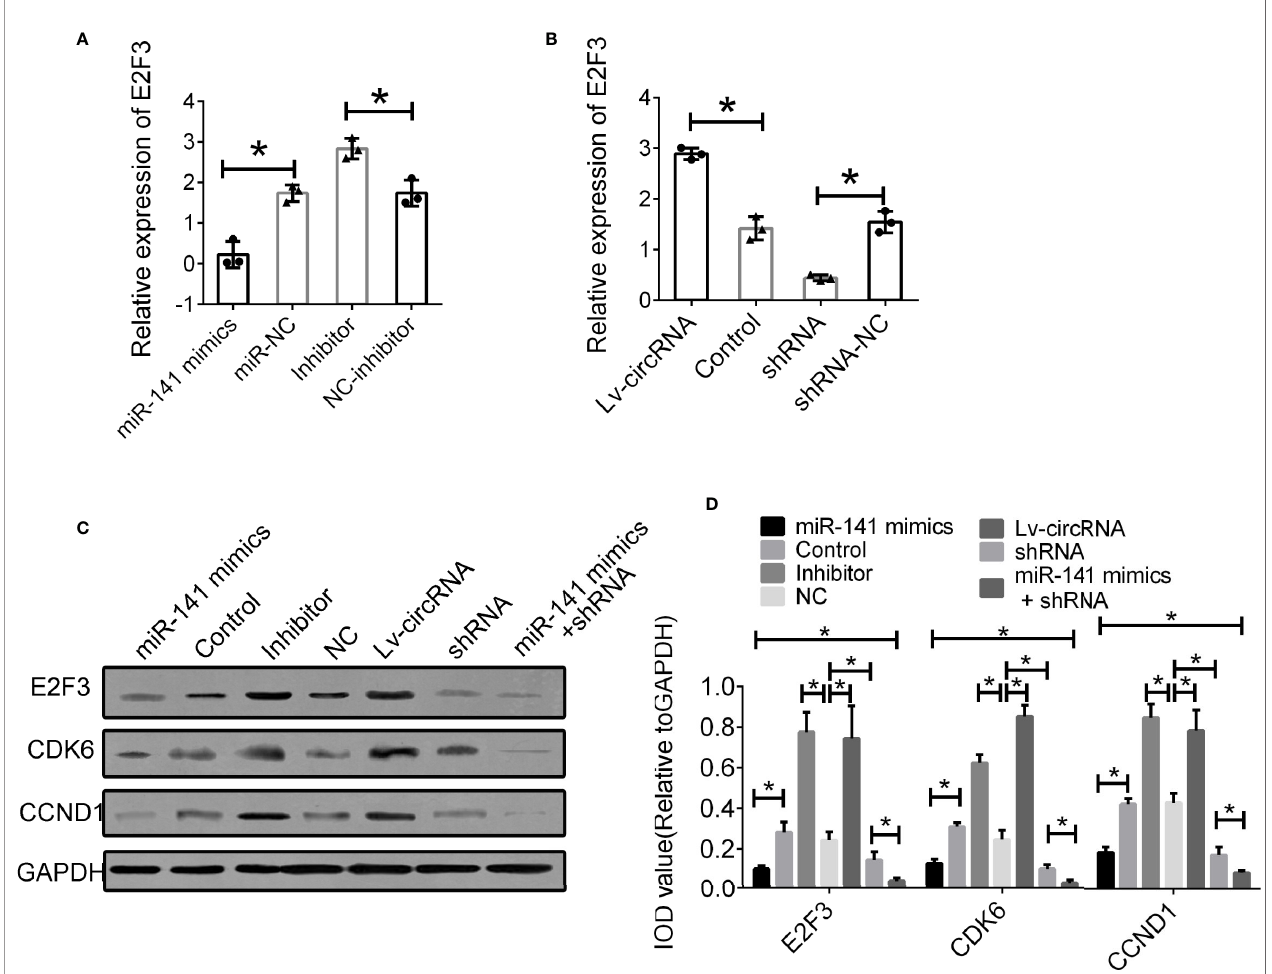
FIGURE 6 | Interaction between circ_0032822, miR-141 and E2F3. (A) Relative mRNA expression of E2F3 in cells treated with miR-141 mimics or inhibitor. (B) Relative mRNA expression of E2F3 in cells treated with circ_0032822 overexpression or shRNA lentivirus. (C) Protein level of E2F3 in cells with different treatment. (D) Integral optical density analysis of immunoblots. The F value for the ANOVA analysis between shRNAs and control group was 13.2, 12.7, 11.6, respectively. Data were presented as mean with SEM. * indicated P <